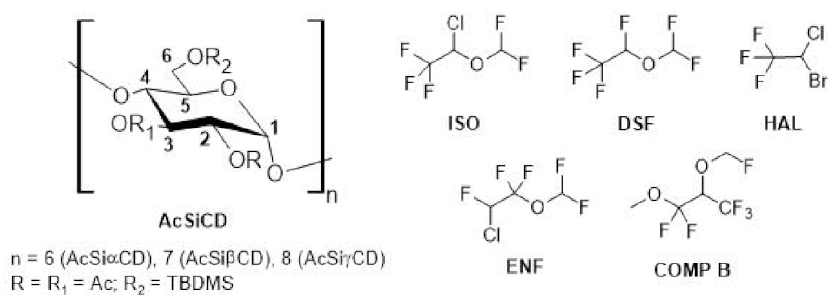
Figure 1. Chemical structures of acetylated-silylated cyclodextrin derivatives and fluori- nated compounds selected for the NMR study. Ac and TBDMS stand for acetyl and tert - butyldimethylsilyl,